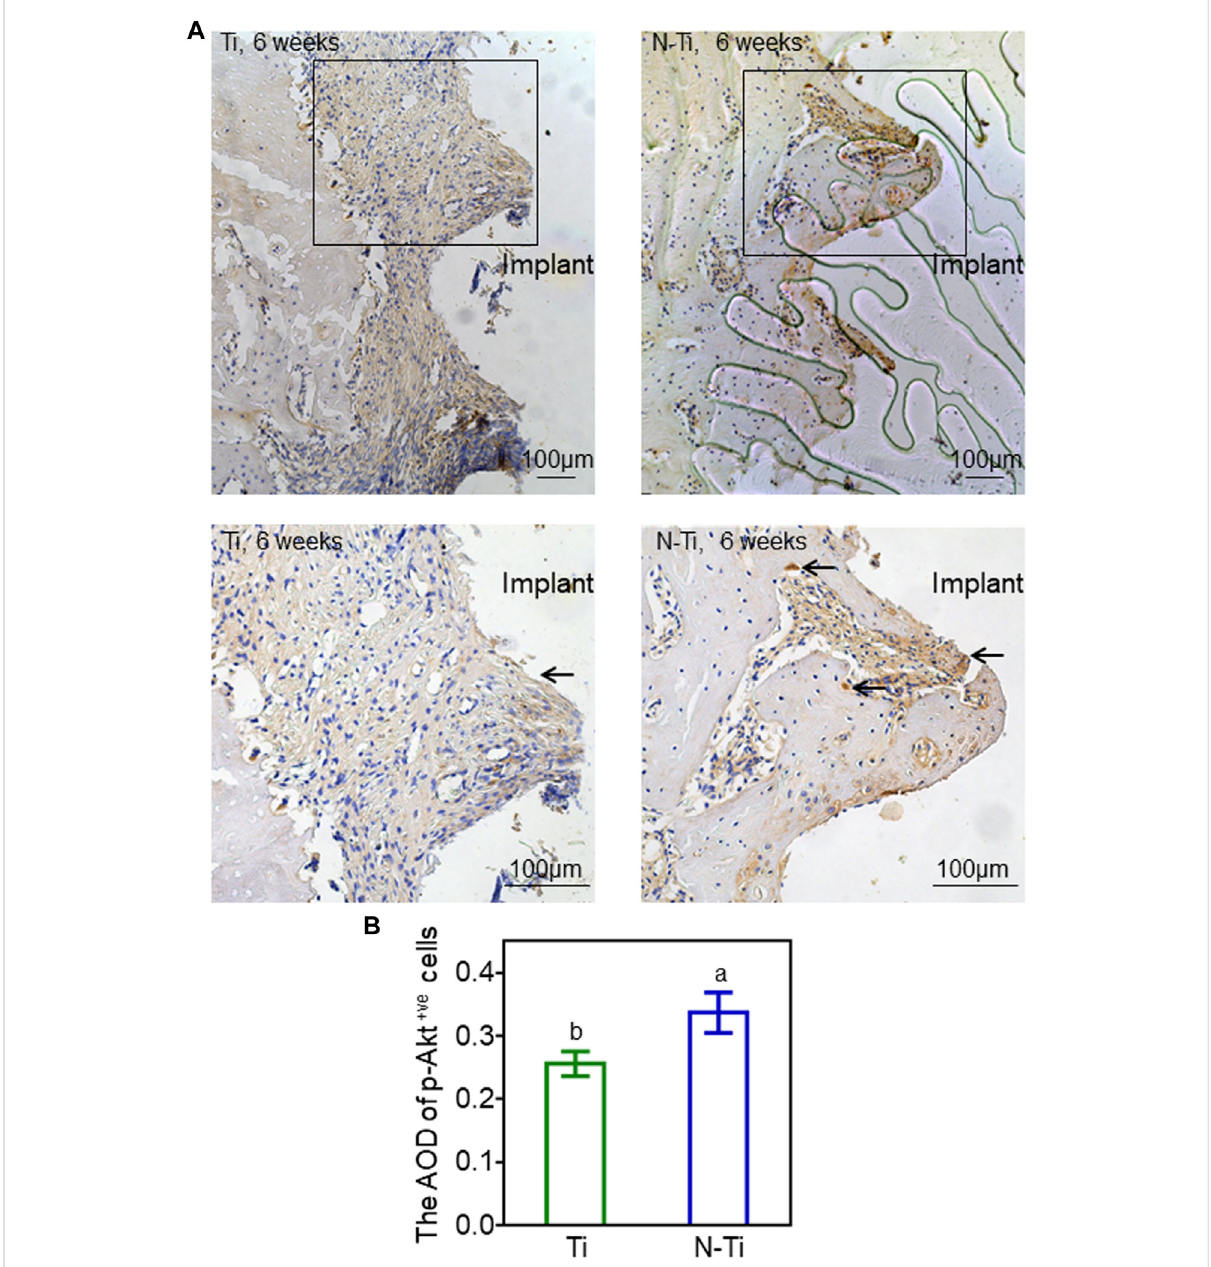
FIGURE 5 Immunochemical staining and analysis of M1 implant regions in rats. (A) The p-Akt staining of Ti and N-Ti samples at 6 weeks post-operation. The p-Akt-positive cells (black arrows) were located in peri-implant bone tissue. (B) Quantitative analysis of p-Akt expression. Results are shown as mean ± SD; n = 6/group. Values with diverse letters are notably different ( p <